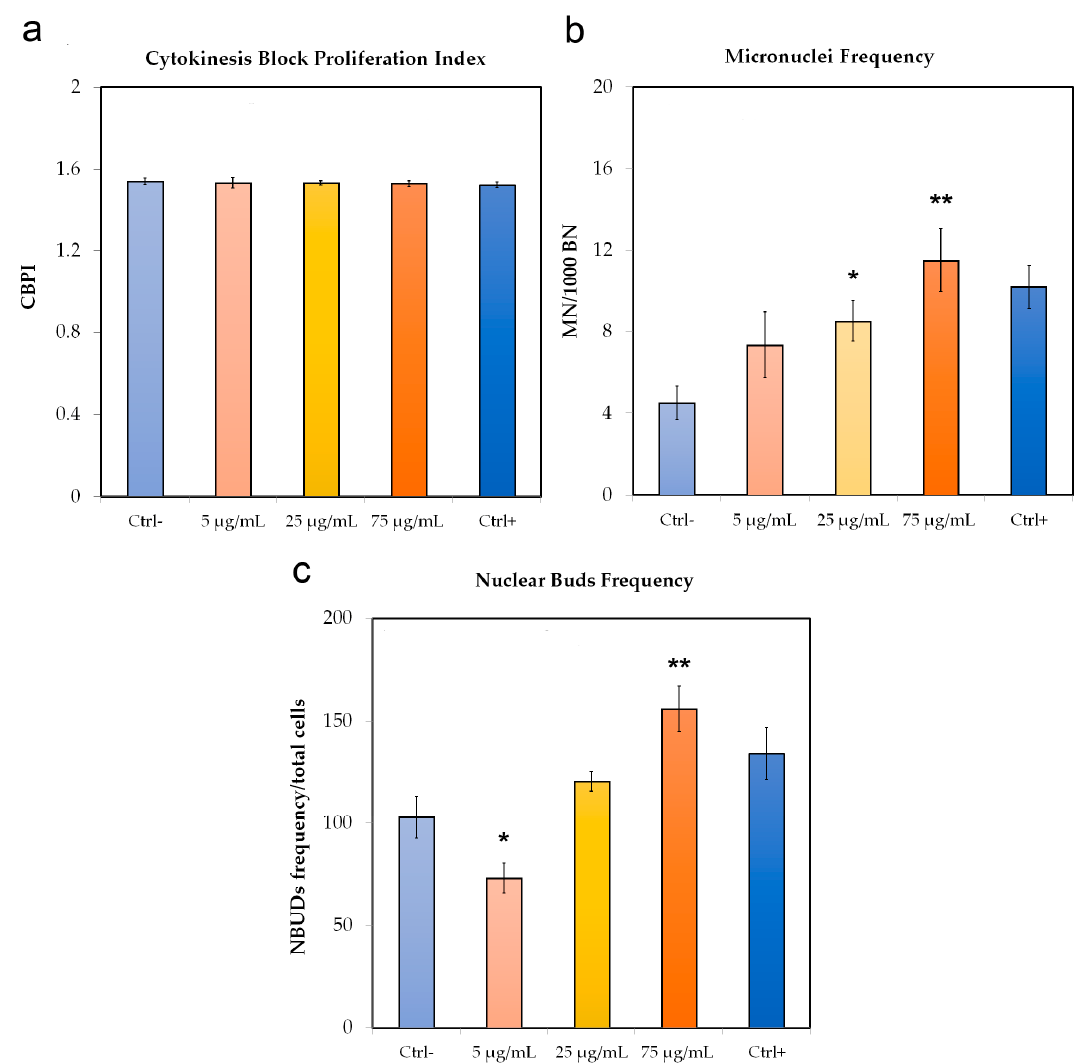
Figure 3. Micronuclei (BNMN), CBPI, and Nuclear Bud (NBUDs) expression in the Hs27 cells treated with polystyrene nanoparticles (PNPs): CBPI, “Cytokinesis Block Proliferation Index” ( a ), Micronuclei ( b ) and Nuclear Buds ( c ) were evaluated at 5, 25, and 75 µ g / mL concentrations after exposure to PNPs. CBPI = ((N ◦ mononucleated cells) + (2 × N ◦ binucleated cells) + (3 × N ◦ multinucleated cells)) / (total cell number). The number of micronuclei refers to 1000 binucleated cells. The number of Nuclear Buds refers to a total of 1000 binucleated cells. Colchicine (5 µ g / mL) was used as a positive control. Significance values * = p < 0.05; ** = p < 0.005; *** = p < 0.0005; error bars represent the standard error of the mean.